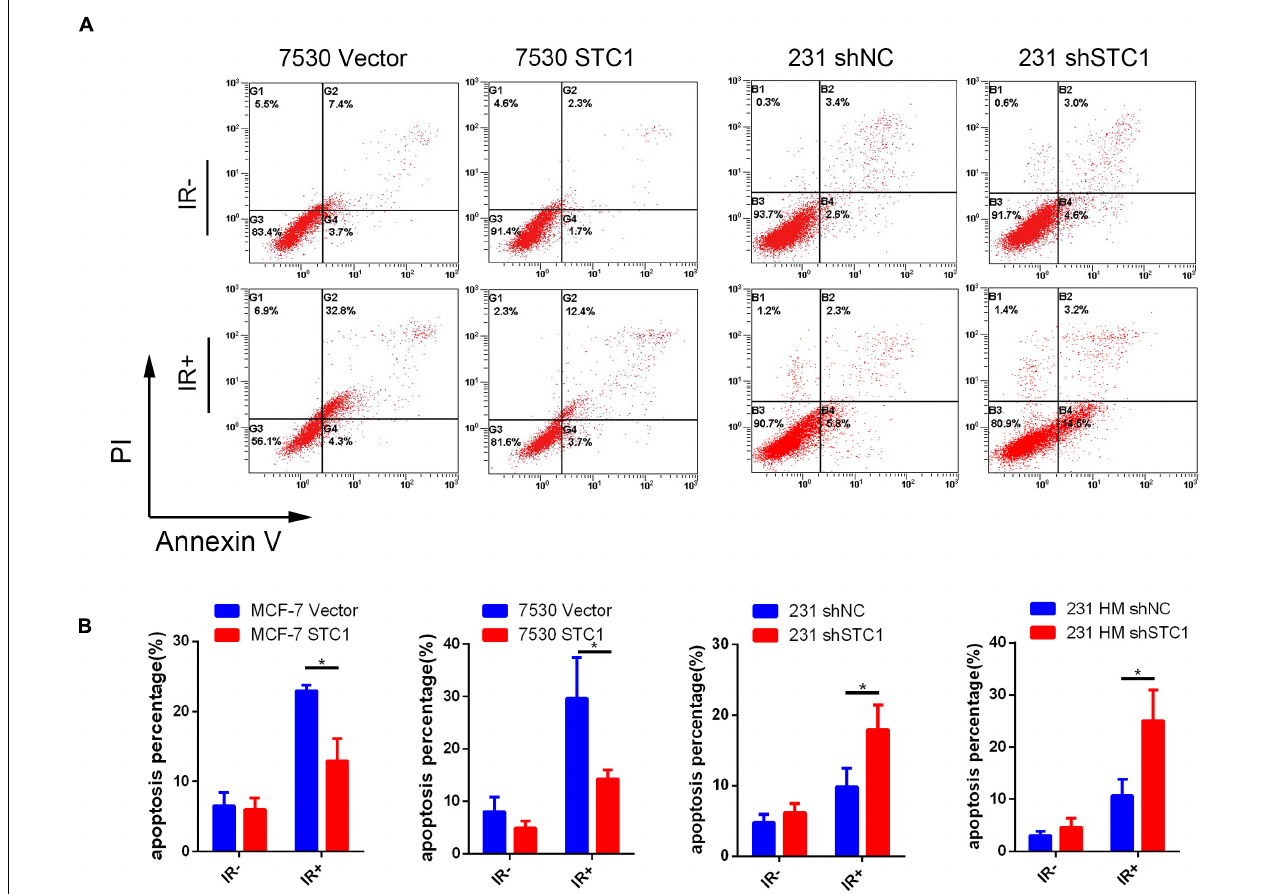
FIGURE 3 | STC1 decreases cell apoptosis after irradiation. Cells were treated with a dose of 8-Gy X-rays, and apoptosis was then measured by flow cytometry in MCF-7 STC1, ZR-7530 STC1, or 231 shSTC1 cells and their corresponding control cells. (A) Representative images of apoptosis assay. (B) The percentage of apoptotic cells. Data are shown as mean ± SEM. P -value was determined by two-tailed unpaired t -test (* P < 0.05). IR +, with radiation treatment; IR − , without radiation